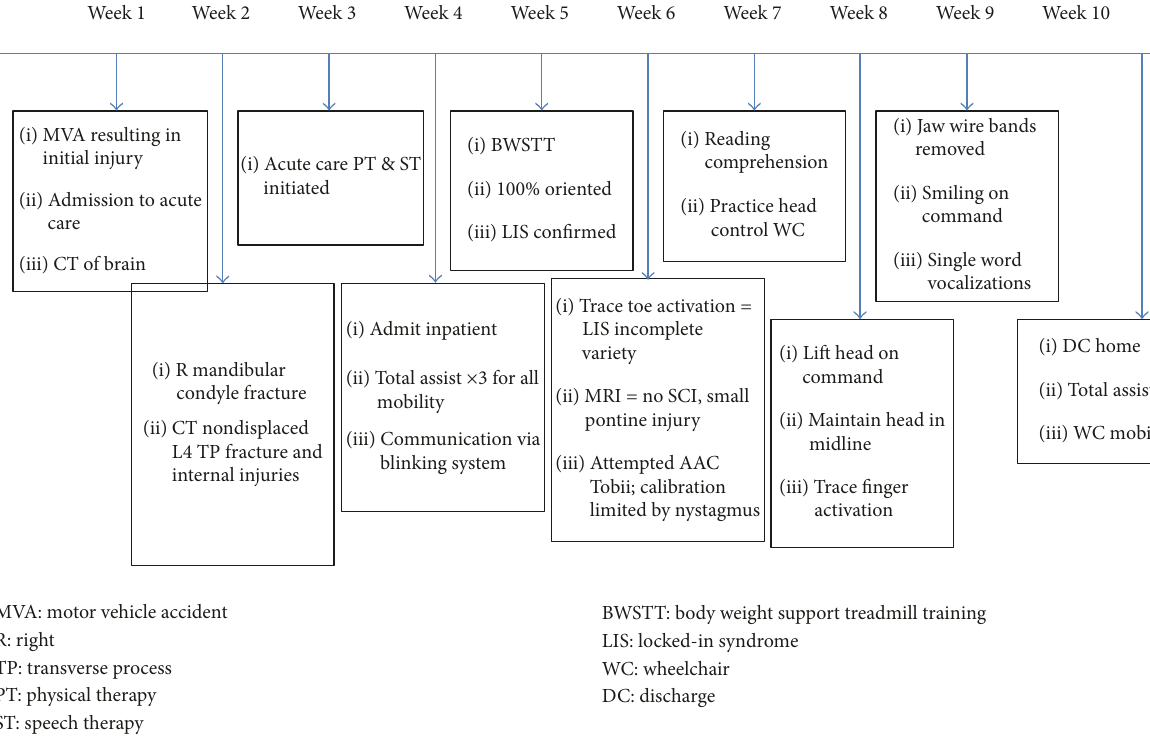
Figure 1: Patient course of care